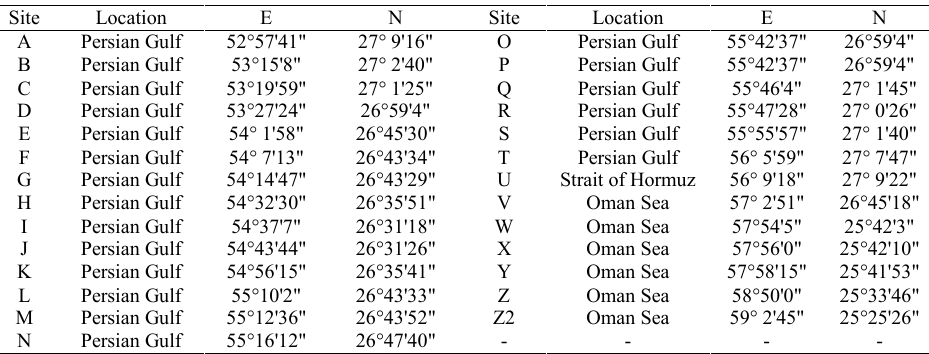
Fig. 10: Areas with a high important spatial value Table 5: Spatial details, high important locations identified